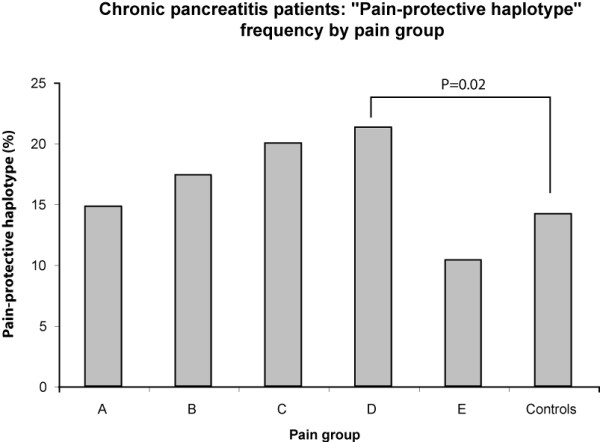
Pain-protective haplotype frequency in CP by pain type. The frequency of the "pain protective haplotype" as percentage of total counts in the CP group subdivided by the subject's response to the pain question. * P = 0.02 comparing group D compared to controls. This was in the opposite direction that was hypothesized, and the value became non-significant after Bonferroni corrected for multiple testing. No other significant differences were detected. "Pain protective haplotype" counts: A = 13, B = 8, C = 32, D = 40, E = 5, Controls = 67.